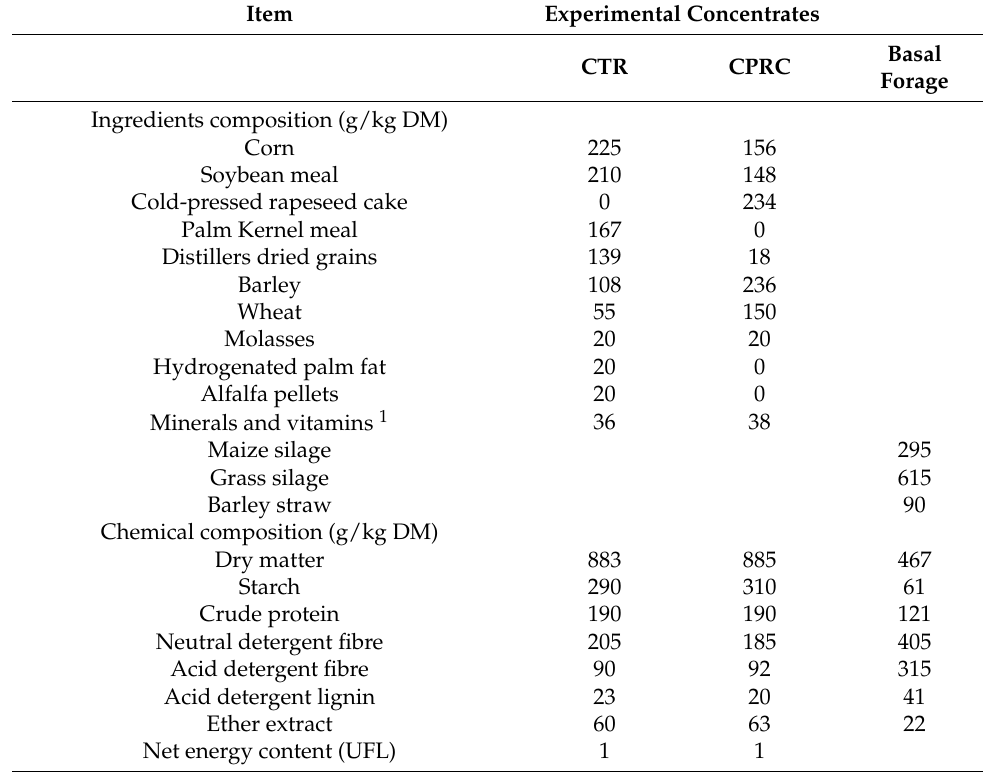
Table 1. Ingredients and chemical composition of basal forage ration and experimental concentrates (CTR, CPRC).